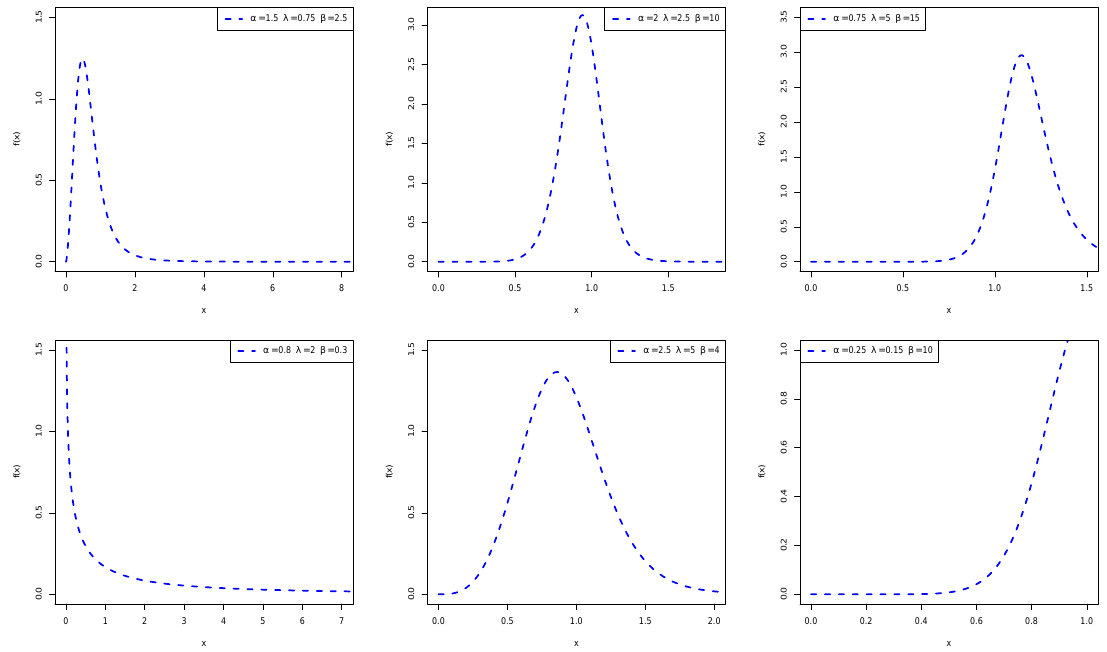
Figure 1. Possible shapes of the Ex-LL density function for various values of α , β and λ .